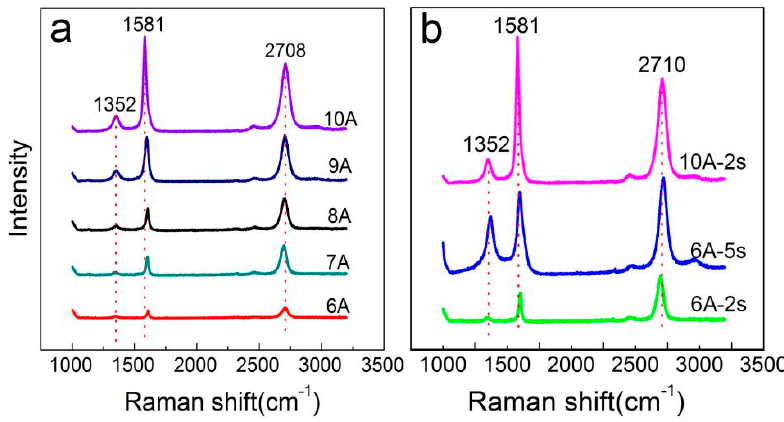
Figure 4. ( a ) Raman spectroscopy of the pulse current ‐ dependent growth of graphene on Si wafer; ( b ) Raman spectroscopy of the pulse width ‐ dependent growth of graphene on Si wafer. ( b ) Raman spectroscopy of the pulse width-dependent growth of graphene on Si